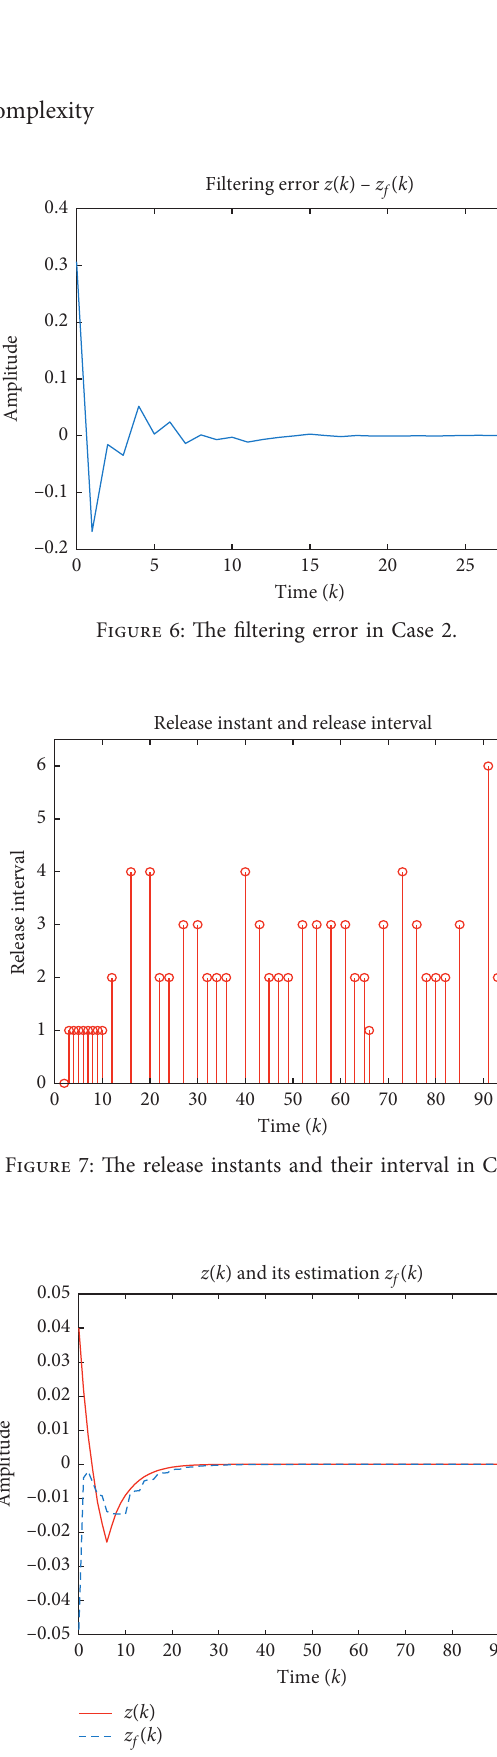
( k ) in Example 2. f